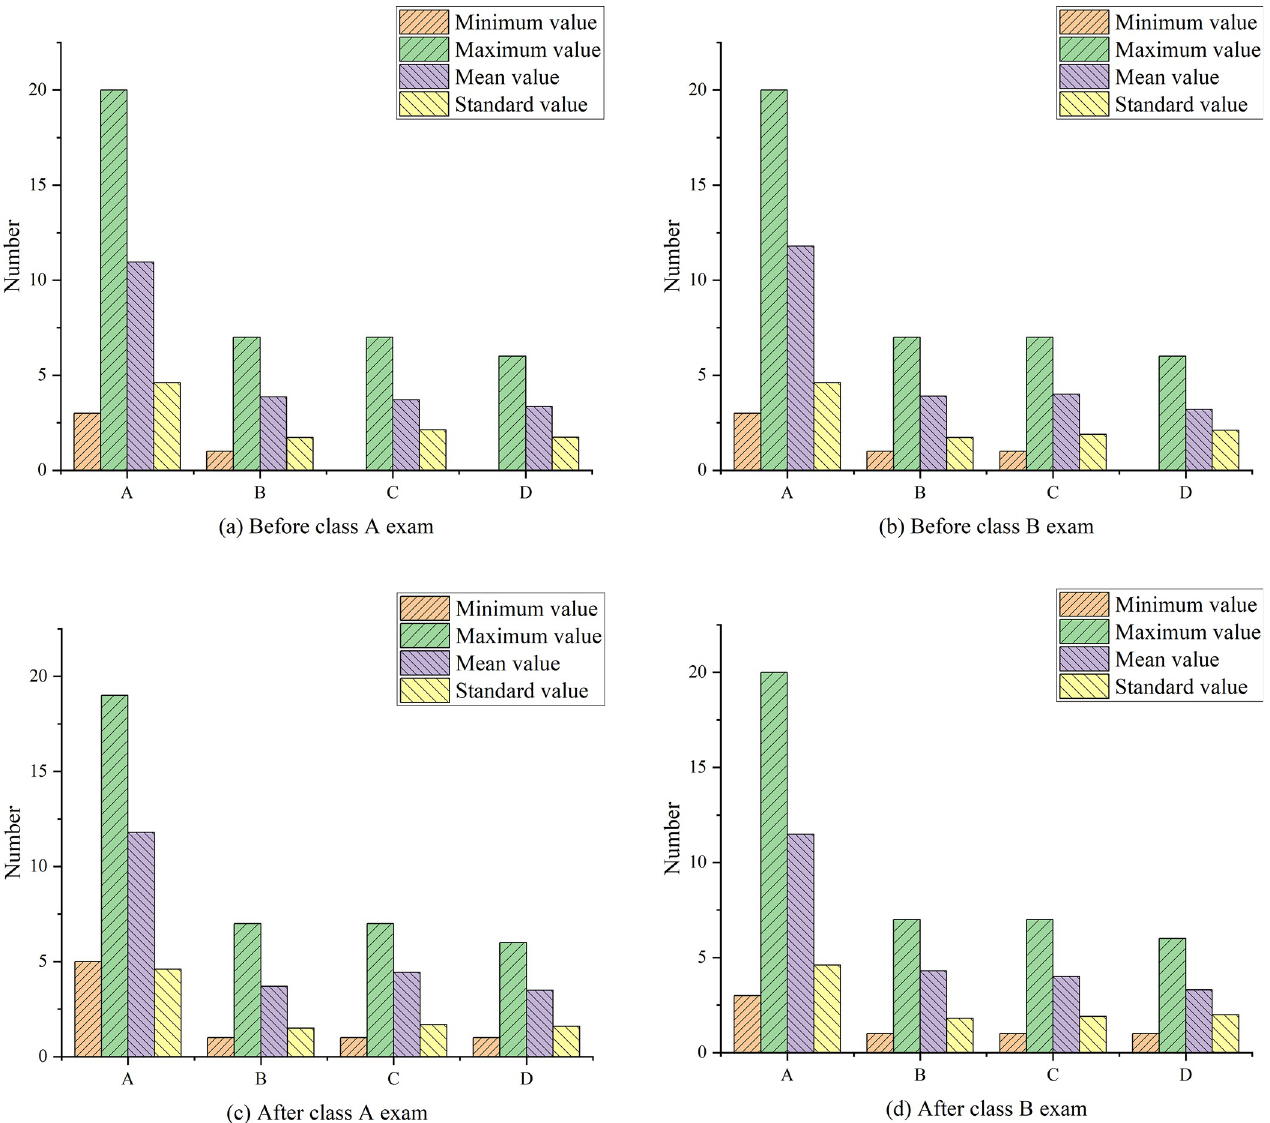
Fig 18. Test paper data statistics before and after the test. Note: A: total score statistics; B: vocabulary spelling questions; C: vocabulary definition questions; D: vocabulary use questions.